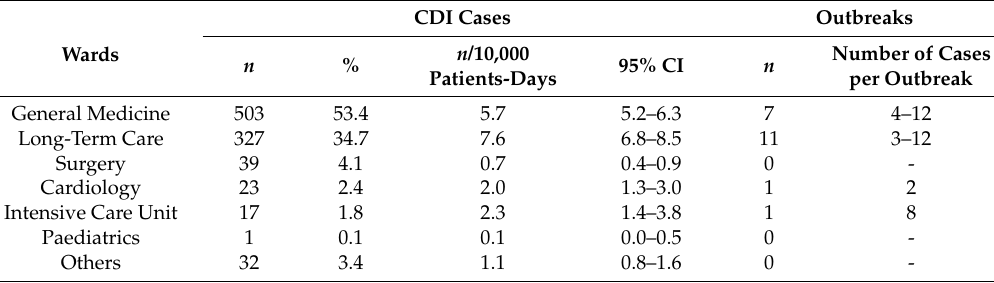
Table 3. Overall incidence of CDI stratified per wards, 2010–2015.